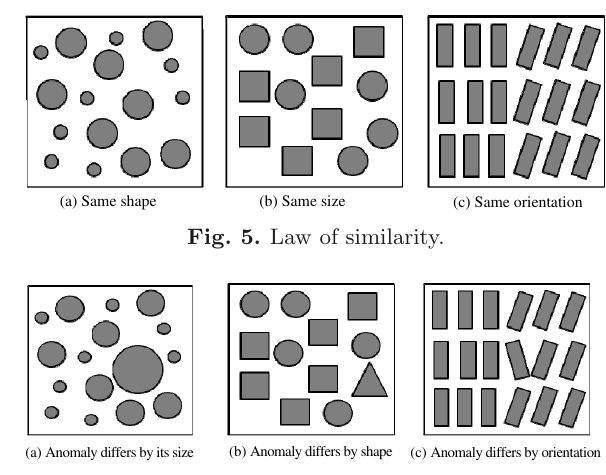
Fig. 6. An anomaly in the case of similar